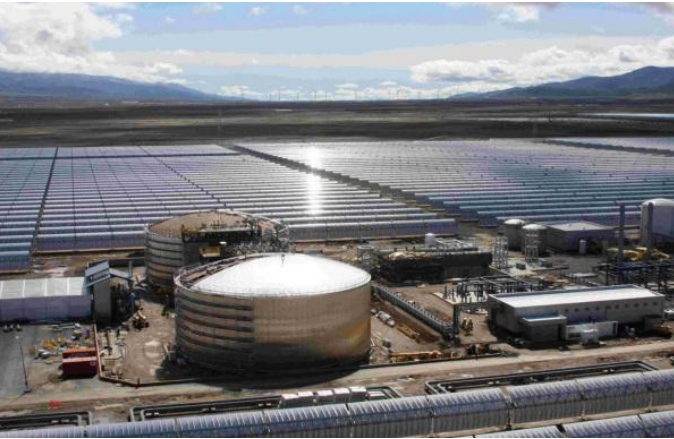
Figure 5. Solar thermal power plant in Grenada, Andosol